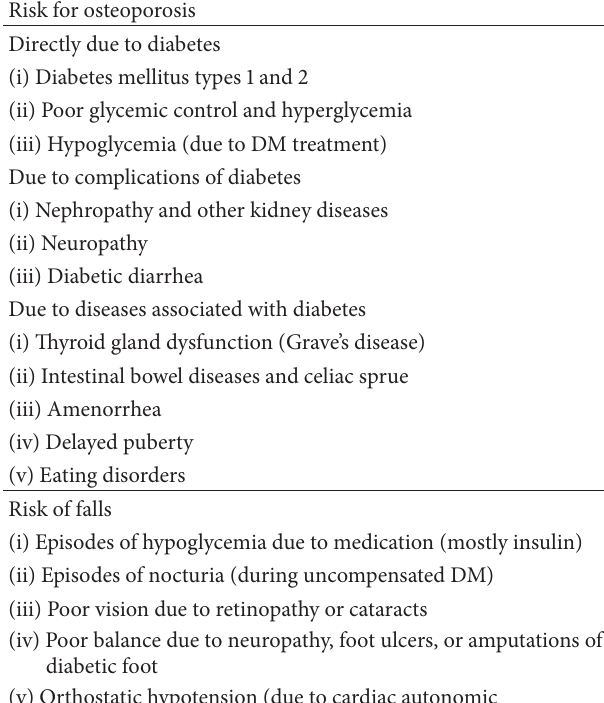
Table 1: Risk factors for osteoporotic fractures in diabetes (modified according to